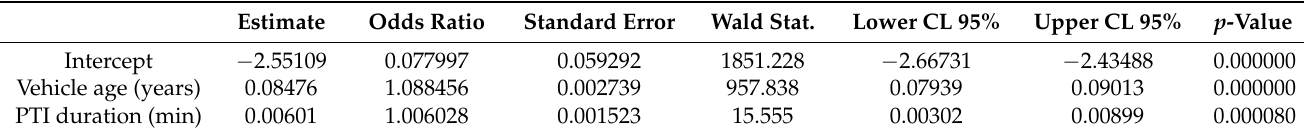
Table 1. The results of binary logistic